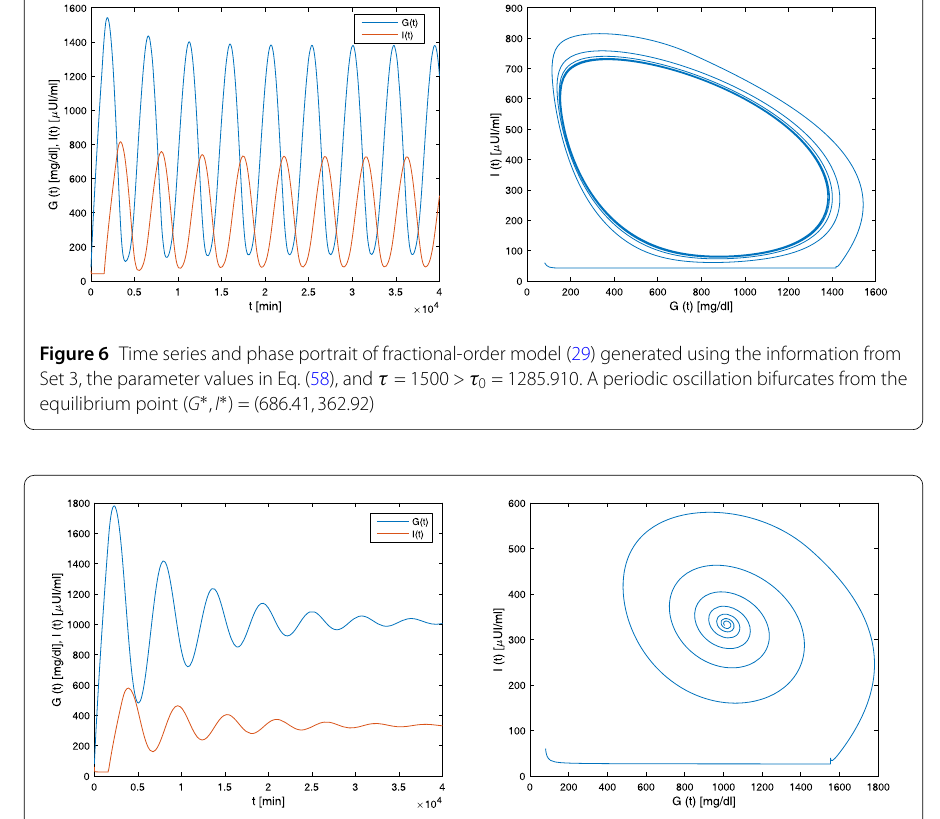
Figure 7 Time series of fractional-order model (29) generated using the information from Set 4, the parameter values in Eq. (58), and τ = 1400 < τ 0 = 2089.425. The positive equilibrium ( G ∗ , I ∗ ) = (1018.09,334.39) of the system is asymptotically